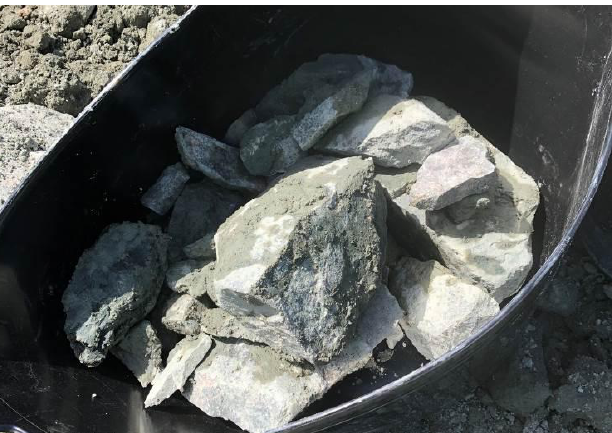
Figure 8. Granite shards from the volume below the grouping of fractured granite at 4.7 ± 0.1 m are shown. The rocks are covered with the fines from the clay-sand mixture which distorts their natural colors. Although rocks that are similar to the larger samples in Figure 8 were found on the surface of the peat, no collection of rocks similar to the single shattered boulder was found on the surface.